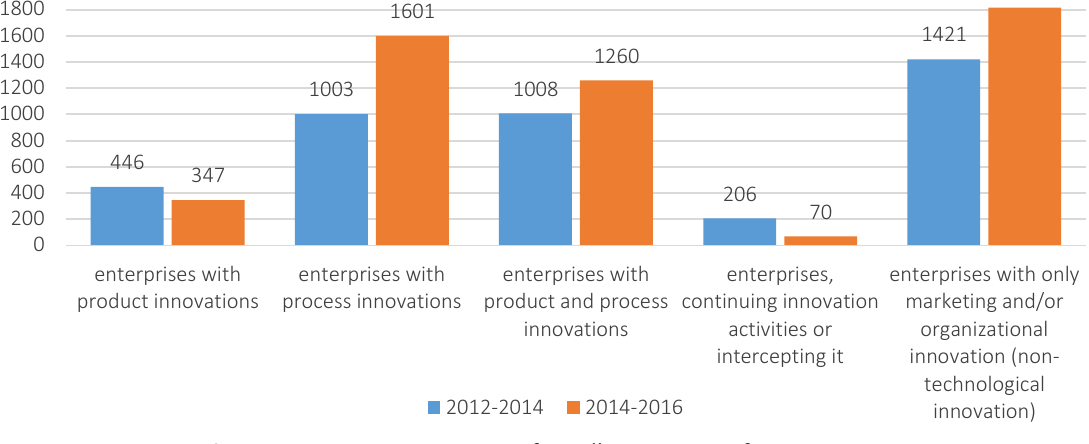
Figure 5. Innovative activity of small enterprises for 2012–2016